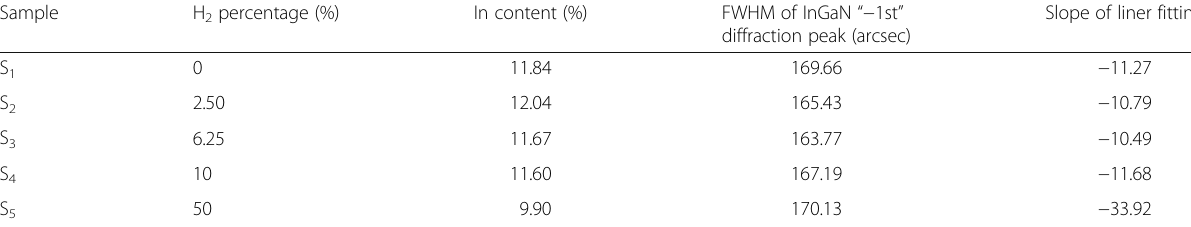
Table 1 Structure parameters of InGaN/GaN MQWs determined by HRXRD fitting Sample